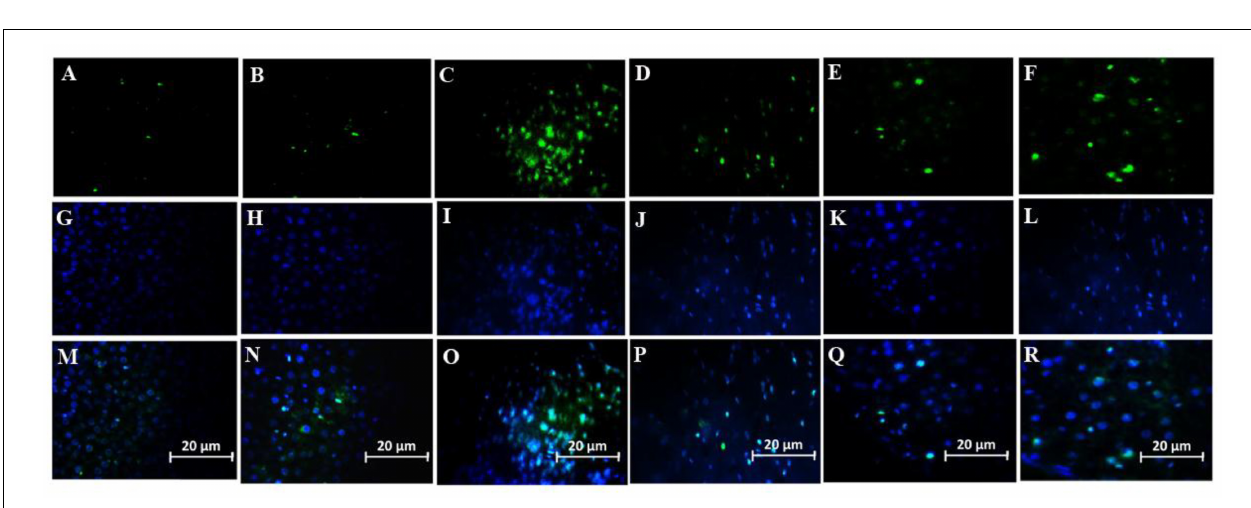
FIGURE 7 | The expression percentage of anti-beta amyloid (A) and anti-IBA1 (B) in the brains of all six studies groups. (* P < 0.05) as compared with control and sham group. (# P < 0.05) as compared with G-SDF and SDF-1 groups. (& P < 0.05) as compared with A β .